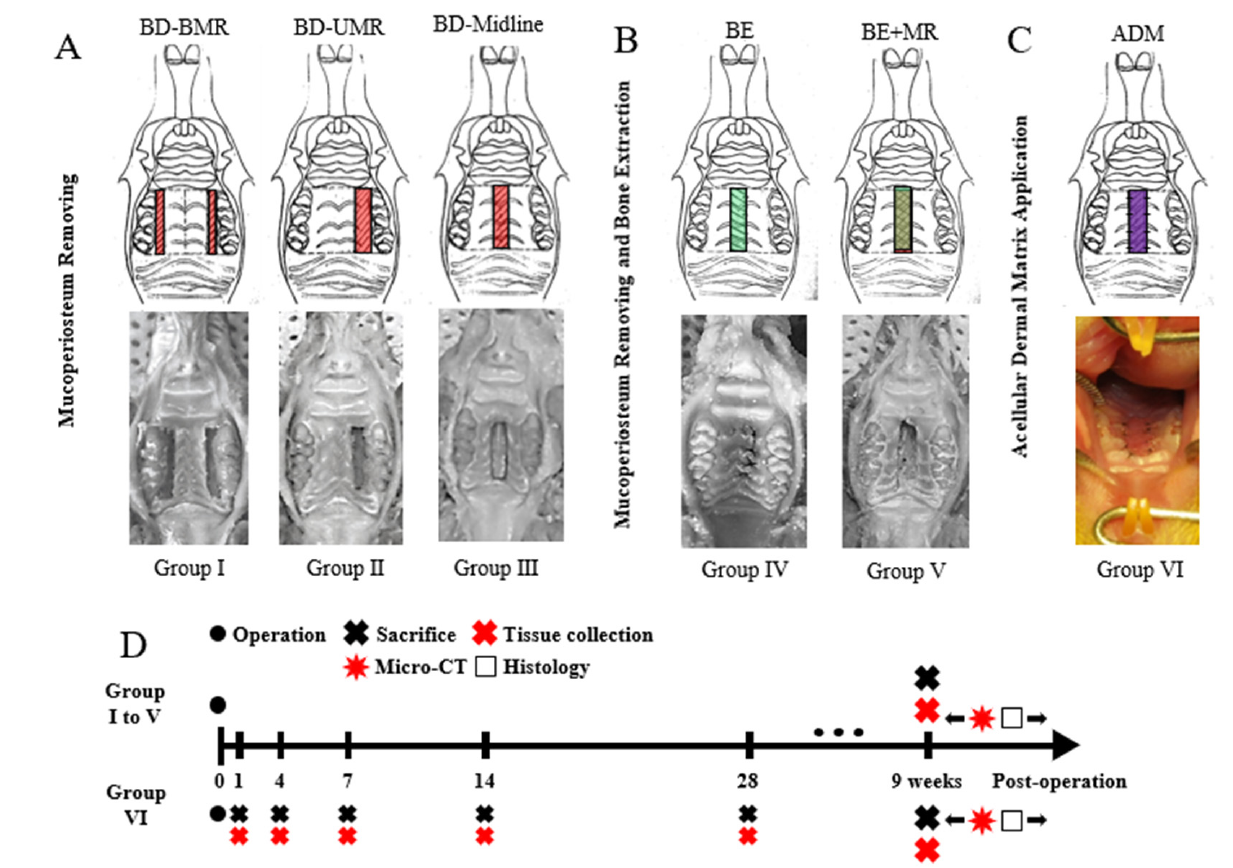
dermal matrix (ADM) (ZH-BIO, Yantai, China) to cover bone denudation (Figure 1C). without tension to cover the bone denudation. For observing the tissue healing process, an extra six rats were needed for sample harvesting of six-time points.